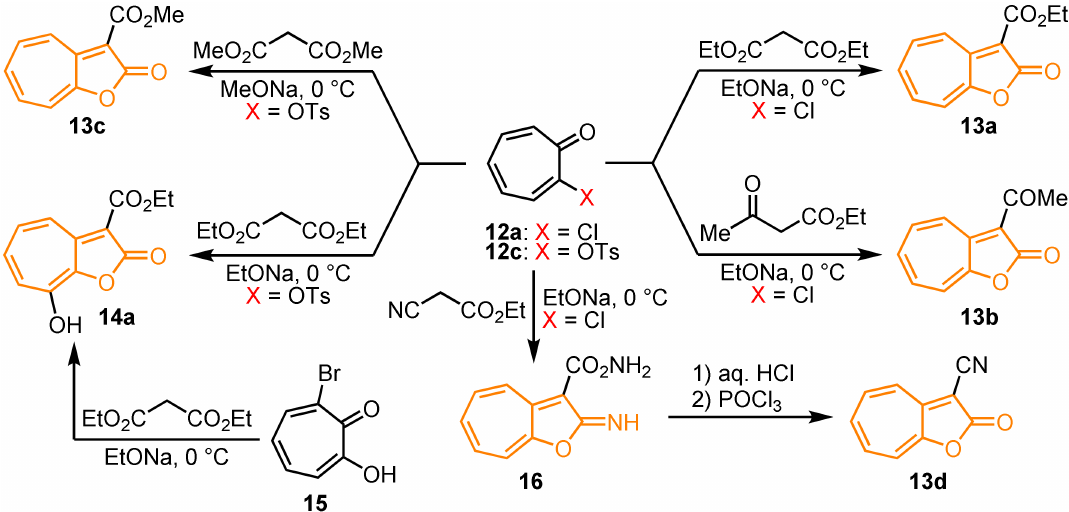
Scheme 4. Preparation of 2 H -cyclohepta[ b ]furan-2-ones with carbonyl and cyano functions at the 3-position.